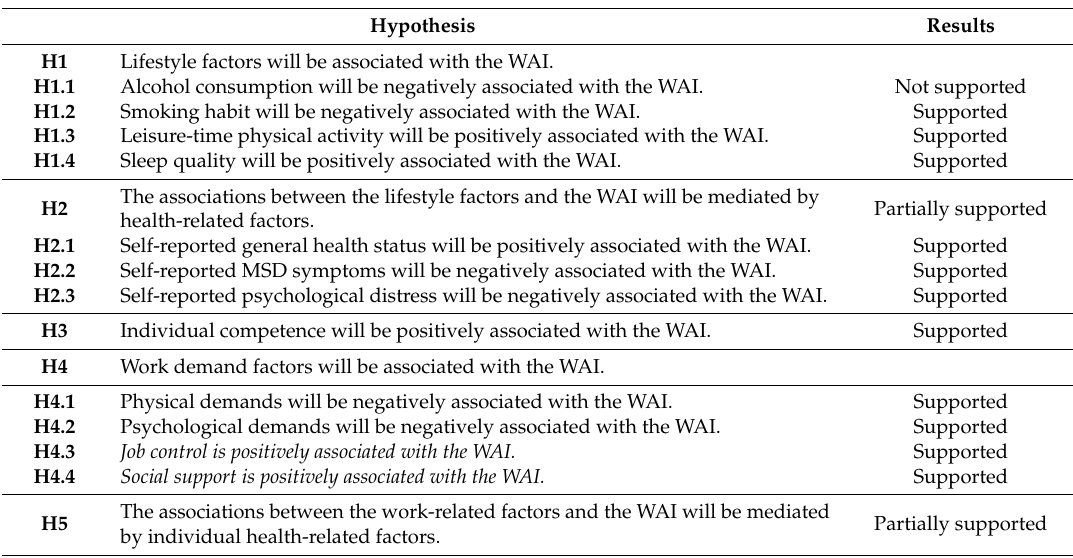
Figure 2. Path analysis for the WAI model (Only the significant paths are shown). Regression coefficients are shown on the respective paths. Table 5. Results of hypothesis testing.